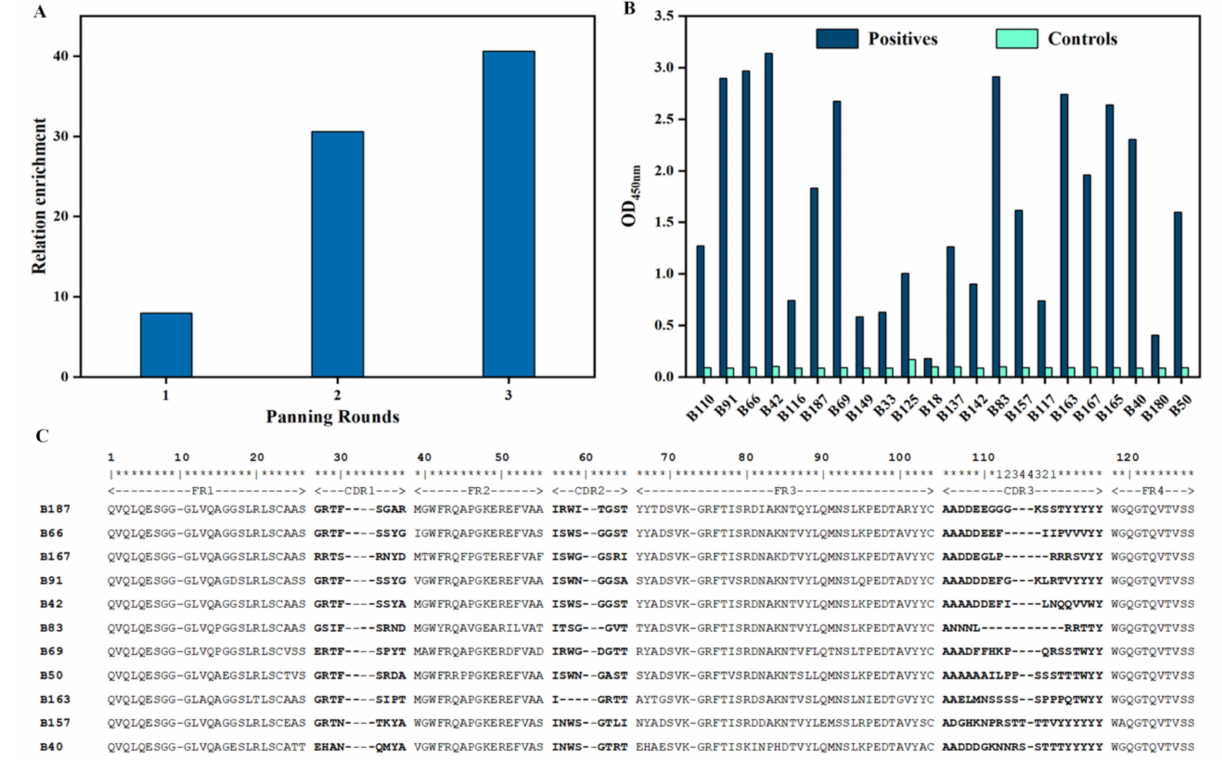
Figure 2. Selection and sequence of selected Nbs from the immune library. ( A ). Lupine protein-specific VHHs were enriched after each round of biopanning in comparison to control wells without antigen coated. ( B ). PE-ELISA for 190 colonies after three-rounds of panning. Only the colonies are shown that yielded an absorbance signal at least 2-fold higher than the signal of negative controls (no antigen coated in wells). ( C ). Twelve different amino acid sequences of lupine protein-specific VHHs were identified. The amino acid sequences of the nanobodies were aligned and their antigen-binding loops or complementarity determining regions (CDR) and framework regions (FR) are